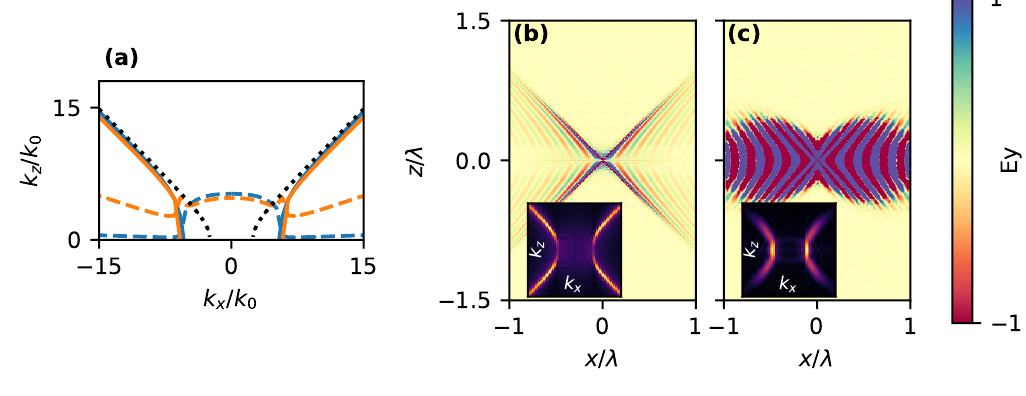
Figure 4. ( a ) Real and imaginary parts of the propagation constant k z for the even mode in the three layer system (details in the text) for losses γ = 0.01 (blue) and γ = 0.1 (orange). The black line shows corresponding HMM dispersion. ( b ) Semi-analytically calculated field profiles for losses γ = 0.01. ( c ) Full-wave simulations of the field profile for losses γ = 0.1. Insets show Fourier transformed fields, showing dispersion of the propagating